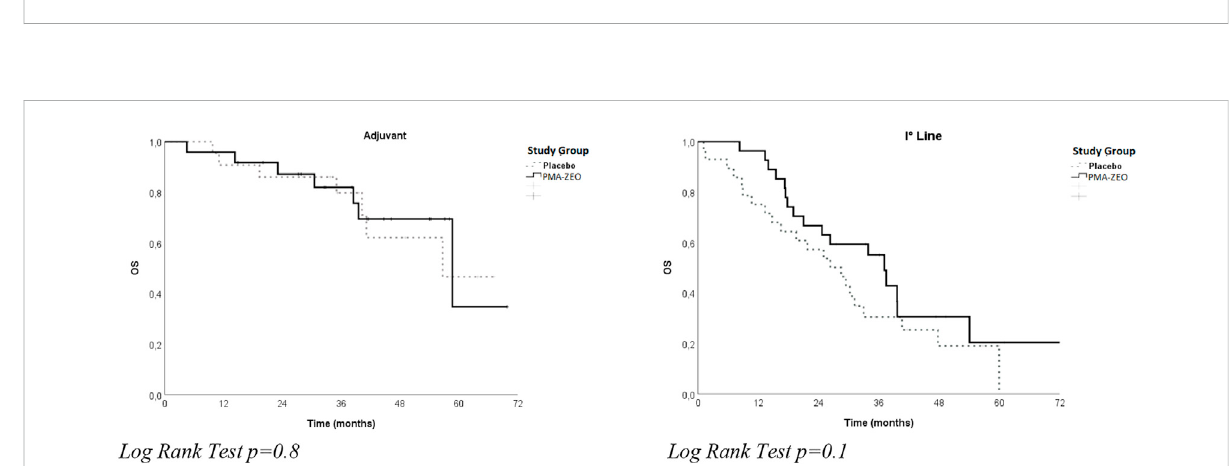
FIGURE 1 Disease-free survival (DFS) and progression-free survival (PFS) for the study groups (Placebo vs. PMA-ZEO).